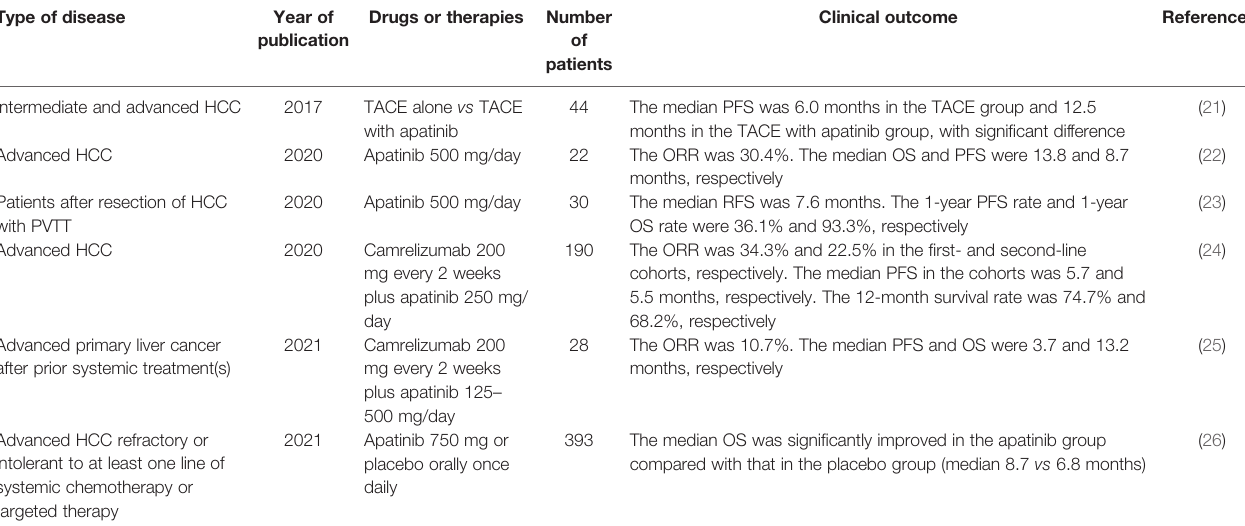
TABLE 2 | Clinical trials on apatinib for HCC treatment included in this